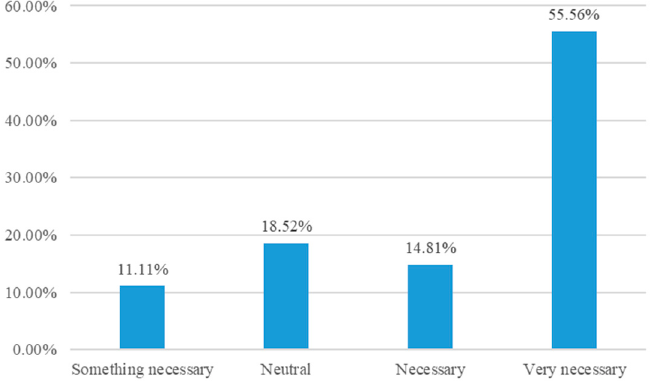
Figure 10. Assessment of the need to regulate the position.